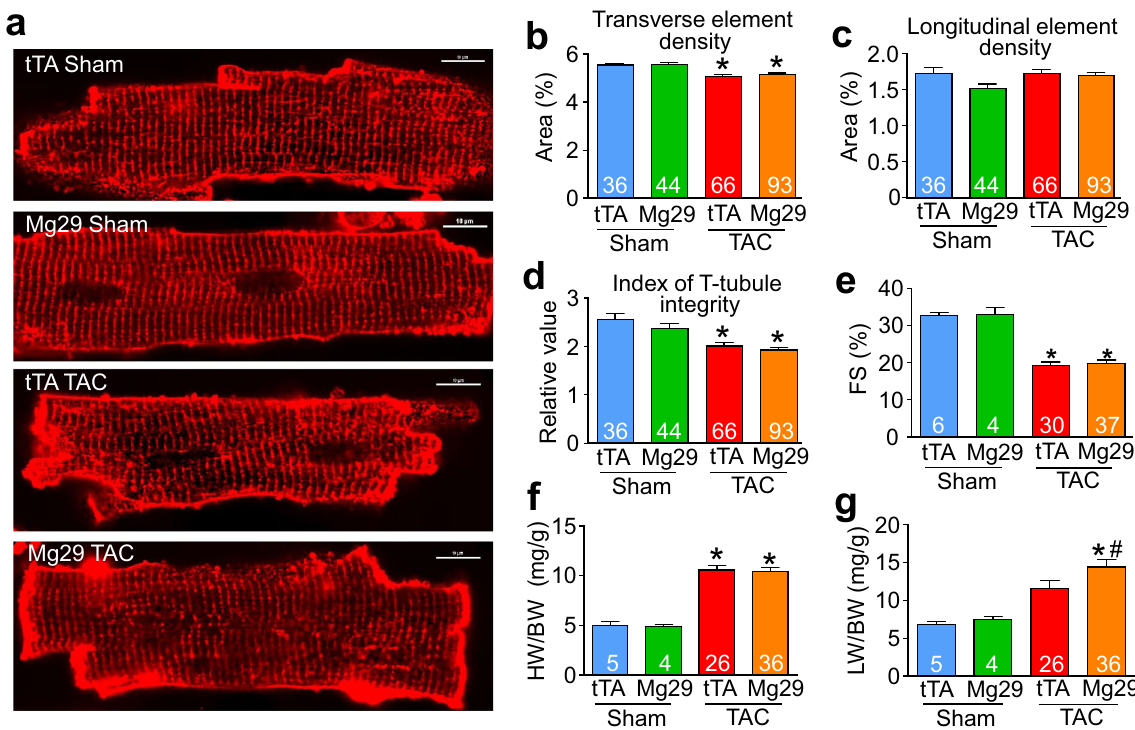
Figure 4. Transgenic expression of Mg29 in the heart does not alter t-tubule morphology or disease progression after long-term pressure overload. ( a ) Confocal images of di-8-ANEPPS-loaded cardiomyocytes isolated from Mg29 Low transgenic or tTA control mice after 12 weeks of TAC or sham control surgery. Densities of cardiomyocyte transverse t-tubule elements ( b ), longitudinal t-tubule elements ( c ), and combined measures of t-tubule integrity ( d ) were generated using AutoTT software. ( e ) Cardiac function as assessed by echocardiographic measures of fractional shortening and ( f ) heart weight normalized to body weight (HW/ BW) ( g ) or lung weight normalized to body weight (LW/BW) from Mg29 Low transgenic or tTA control mice after 12 weeks of TAC or sham control surgery. Number of cardiomyocytes ( b – d ) and mice analyzed ( e – g ) is shown in the bars in each graph. * P < 0.05 versus sham surgery of the same genotype. # P < 0.05 versus tTA of same surgical